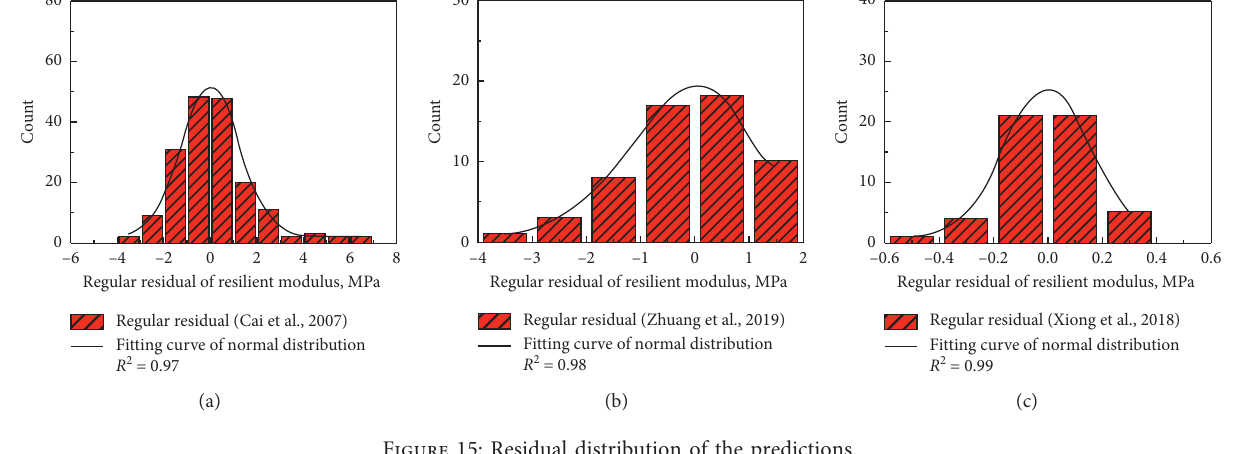
Figure 15: Residual distribution of the predictions.